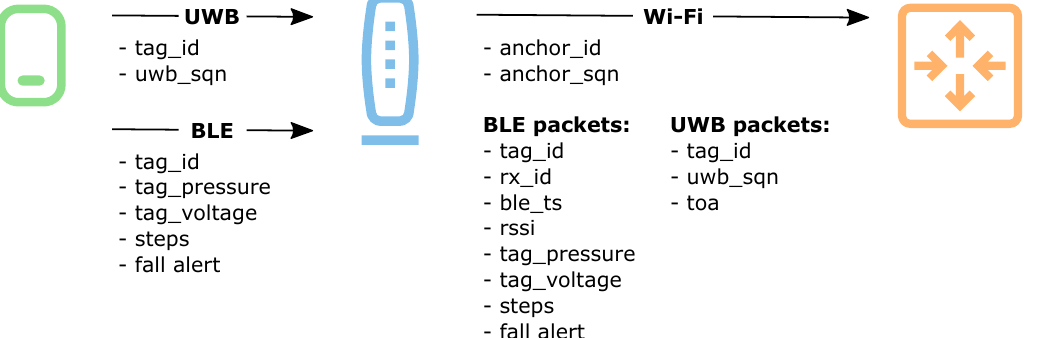
Figure 3. Data transmitted between system devices: a tag, an anchor, and a system